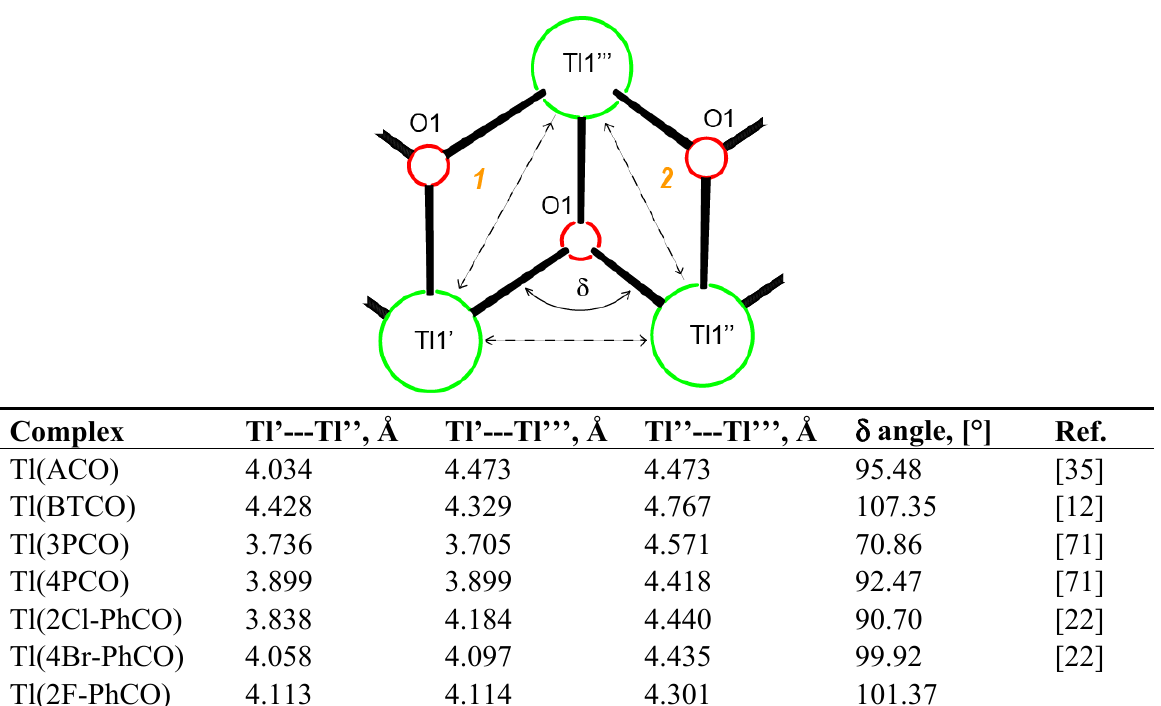
O fused rhombs ( 1 and 2 ) that are formed from the Table 3. Geometry of two different Tl 2 2 centrosymmetric (TlL) dimers and define the double-stranded ladder-type motif of 2 coordination polymer of several Tl(I)